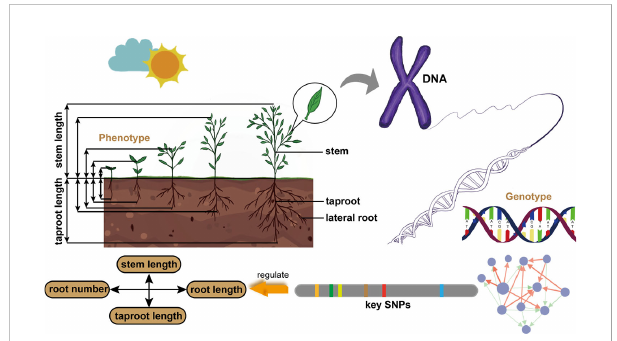
FIGURE 1 Schematic diagram of our model framework. It is applied to the data of stem length and taproot length from Populus euphratica seedlings to identify key QTLs regulating the growth interaction between aboveground and underground, and clarify the architecture of genetic network. It is also used to analyze the data of root number and root length to understand the genetic